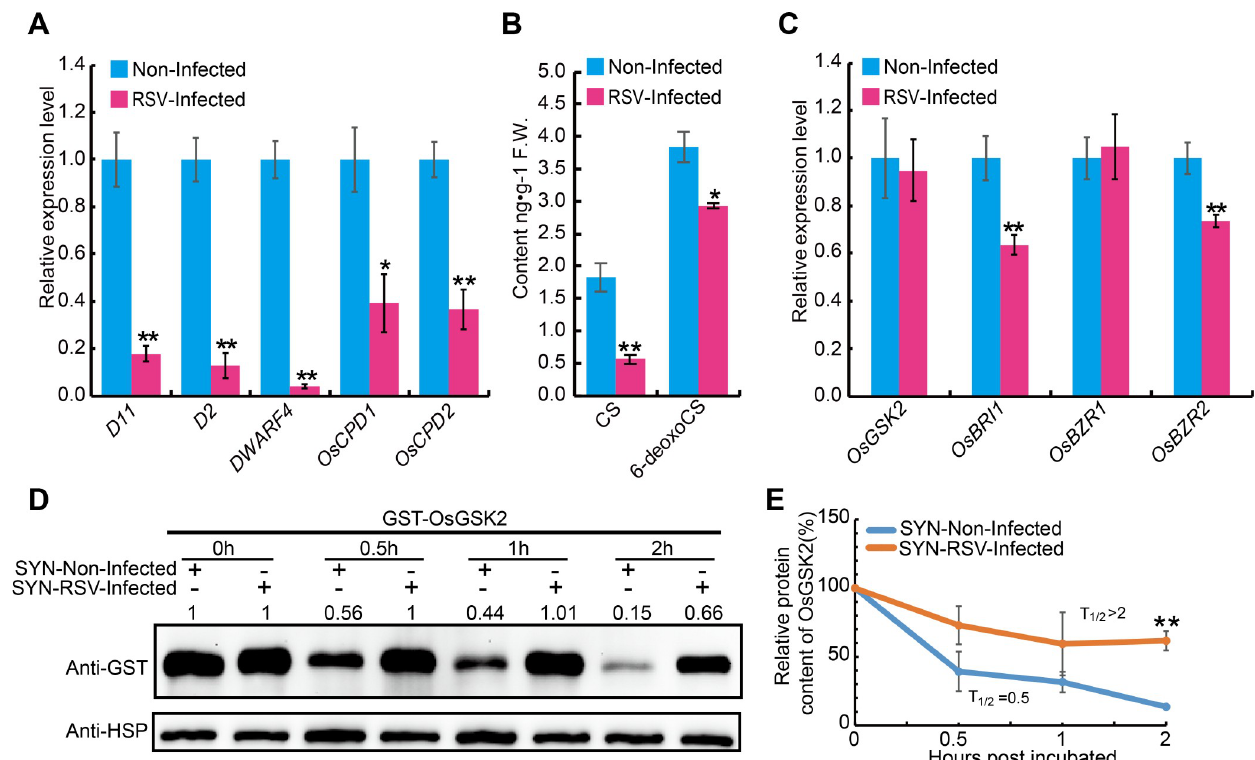
Fig 9. RSV infection suppresses the BR biosynthesis and signal pathway. (A) The relative expression levels of BR biosynthetic genes in non-infected and RSV-infected plants of the susceptible rice cultivar Suyunuo (SYN). (B) Levels of endogenous CS and 6-deoxoCS in RSV-infected and non-infected SYN rice plants. (C) Quantitative RT-PCR analysis showing the relative expression levels of BR signaling-related genes in RSV-infected and non-infected SYN rice plants. (D) Cell-free degradation assay of GST-OsGSK2 incubated with extracts from RSV-infected and non-infected SYN rice plants. OsHSP was used as loading control. The number on the panel indicate the protein level of GST-OsGSK2 relative to its initial value (0 h). The experiment was repeated three times. (E) Half-life plot for cell-free degradation of GST-OsGSK2 in (D). Data are shown as mean ± SEM (n = 3). � P < 0.05, �� P < 0.01 by the Student’s t -test in A, B, C and